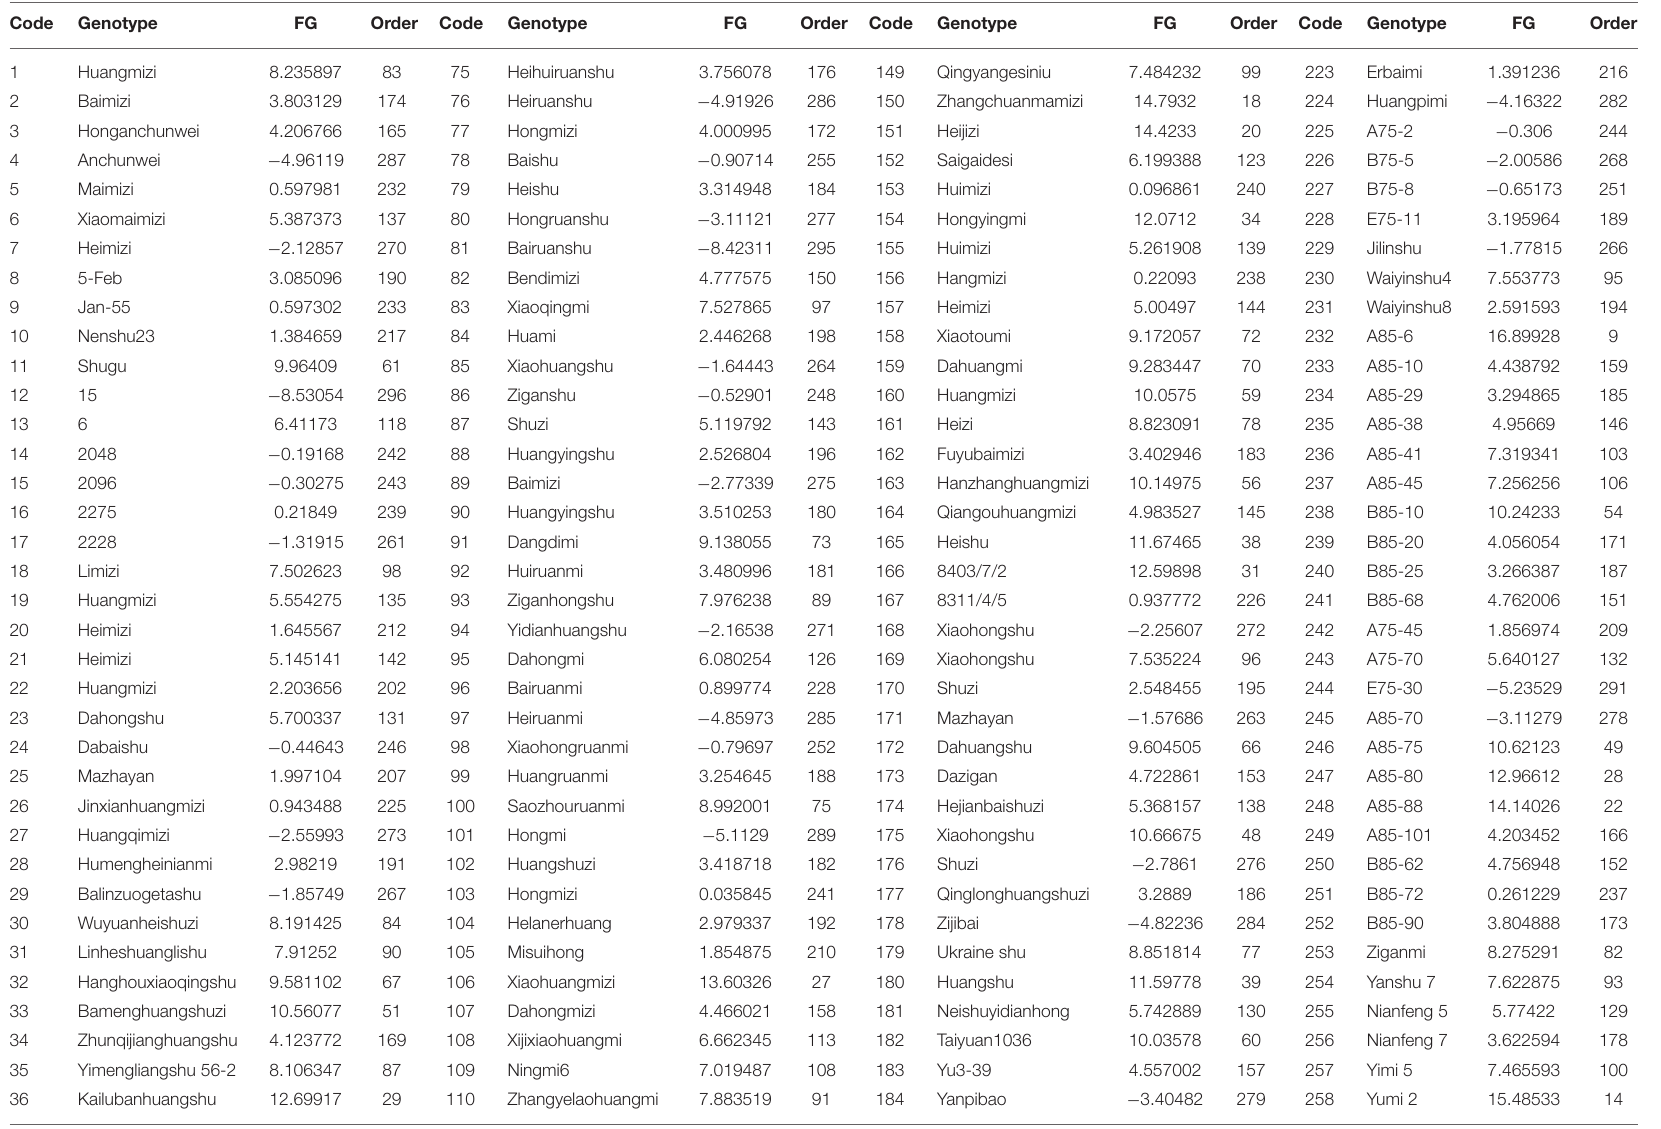
TABLE 1 | The order of alkali tolerance ( F -value) of 296 genotypes